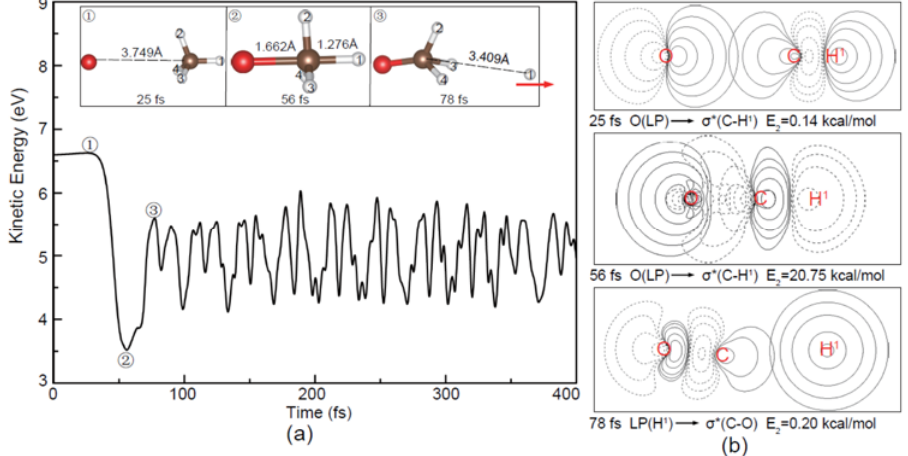
Figure 4. ( a ) Evolution of the total kinetic energy and snapshots in the reaction beginning with the O − center-of-plane attack (6.6 eV); ( b ) The corresponding NBO contour maps at the selected times and E 2 is the hyperconjugative energy. The red arrow in ( a ) shows the translational direction of the product H.